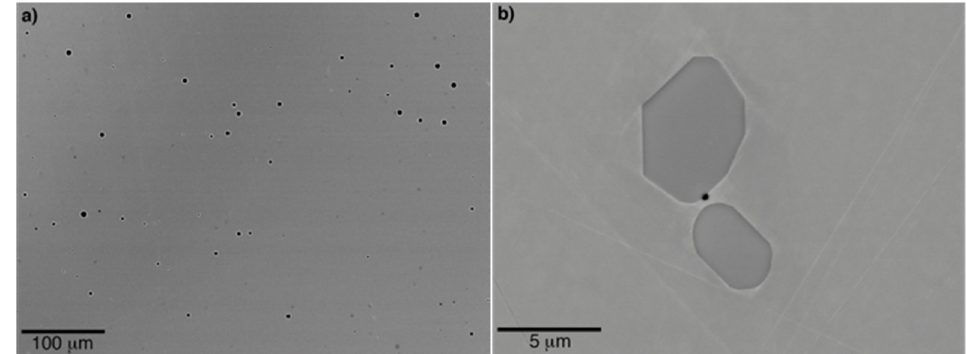
Figure 11. BSE micrographs of Stellite-21 in the 1250 °C 10 h heat-treated state. ( a ) Low magnification image of the microstructure. ( b ) High magnification images of the precipitates.